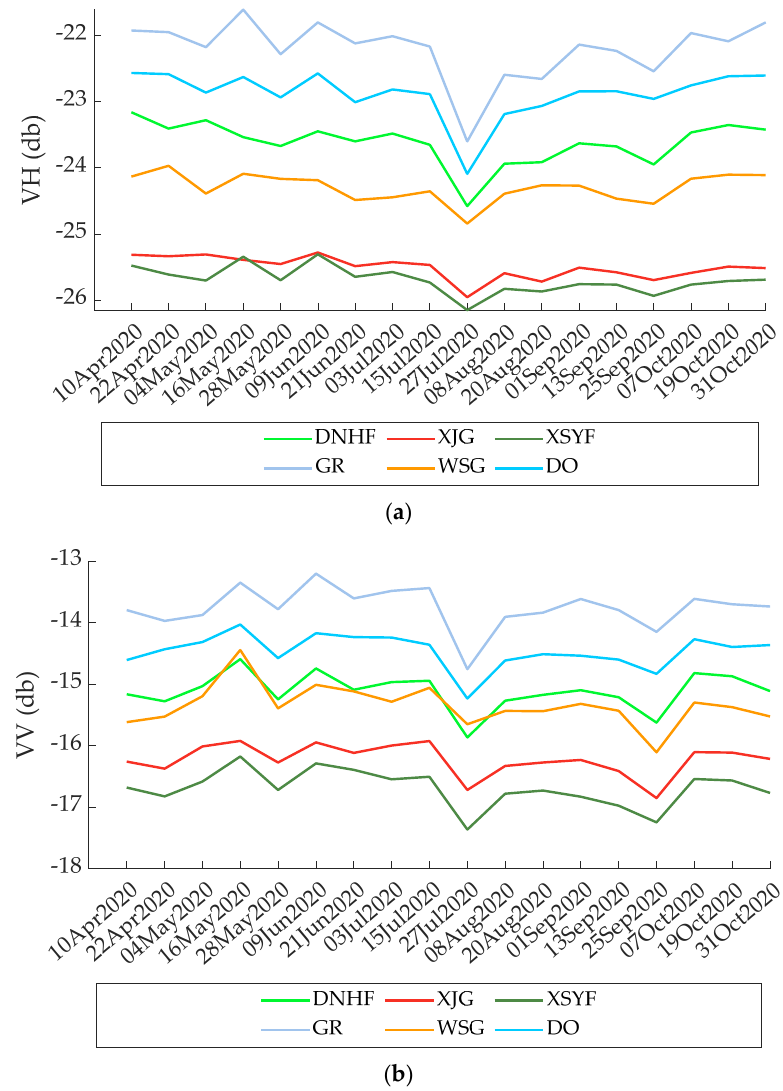
Figure 5. Temporal average backscatter coefficient at ( a ) VH and ( b ) VV channels of different rock units.